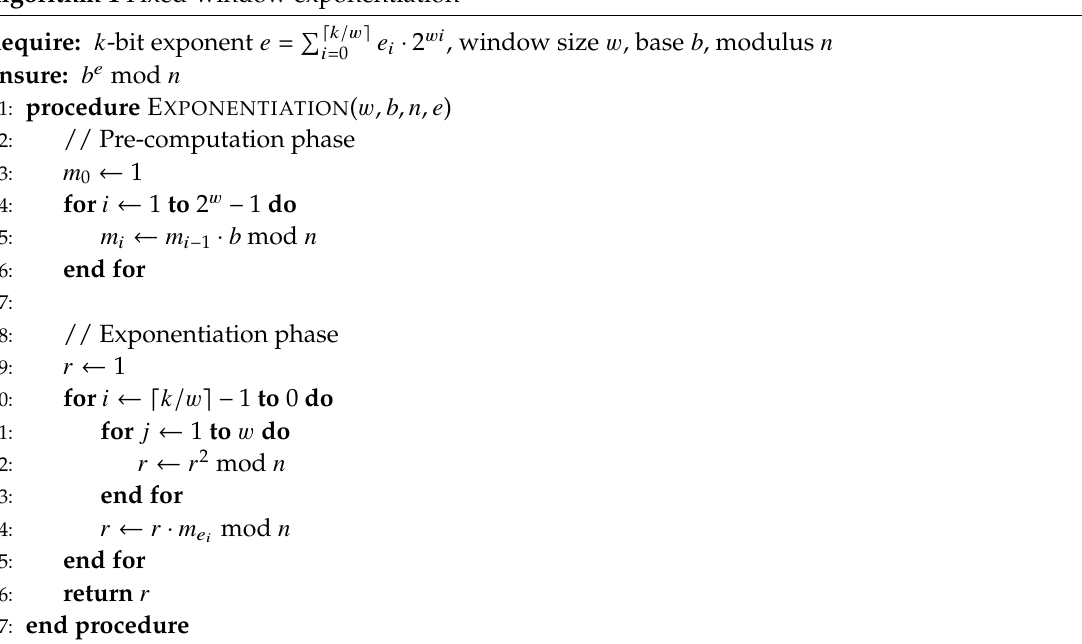
Algorithm 1 Fixed-window